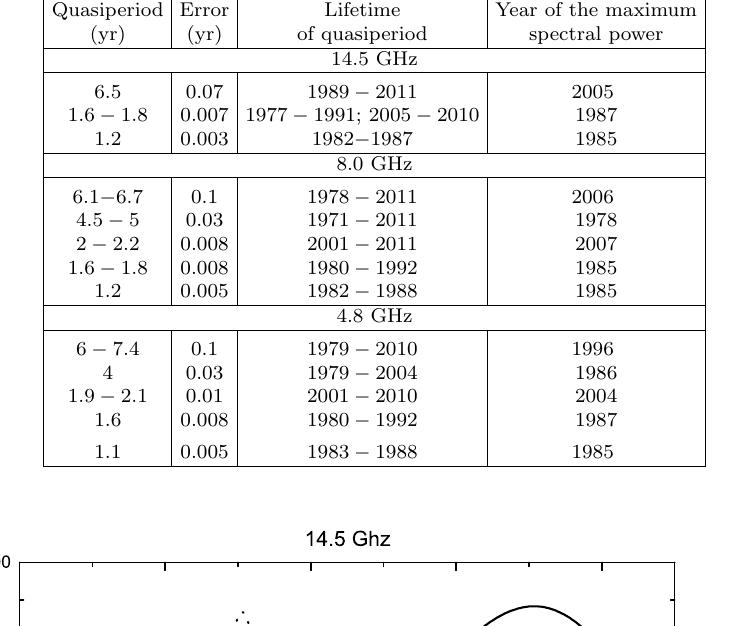
Table 1. The results of wavelet analysis for the data on OJ 287 at the frequencies 14.5, 8.0 and 4.8 GHz.